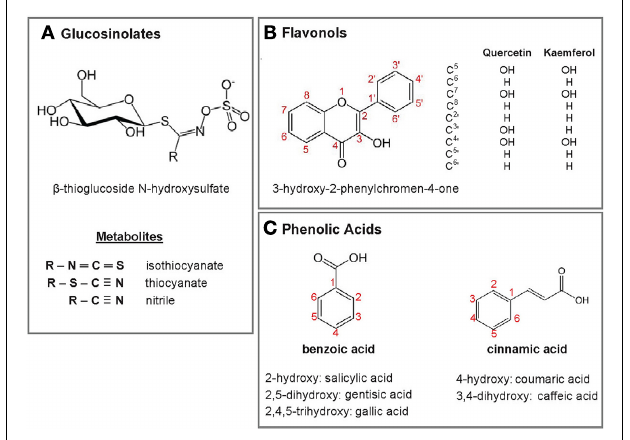
FIGURE 2 | Structural motifs and backbones of major phytochemicals found M. oleifera leaves. (A) Glucosinolates and their metabolites. (B) Flavonol major derivatives. (C) Phenolic acids.Their known derivatives or metabolites are indicated.